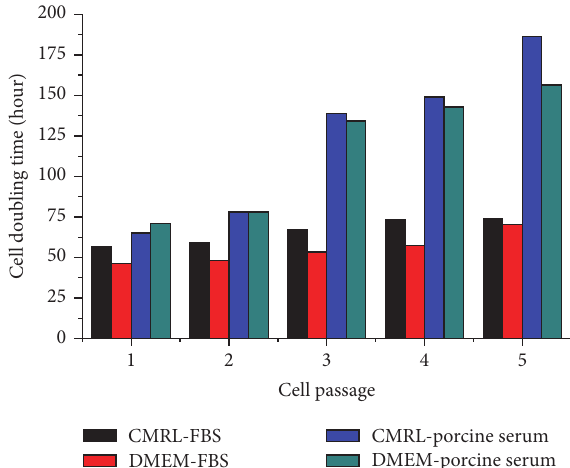
Figure 1: Islet-derived cell proliferation in culture. The doubling time (hours) of islet-derived cells was measured in CMRL and DMEM media supplemented with 10% fetal bovine serum (FBS) and 20% porcine serum (PS) at the indicated passages.